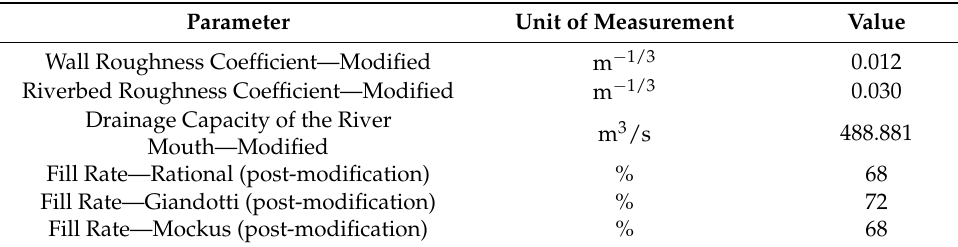
Table 9. Modification of the roughness